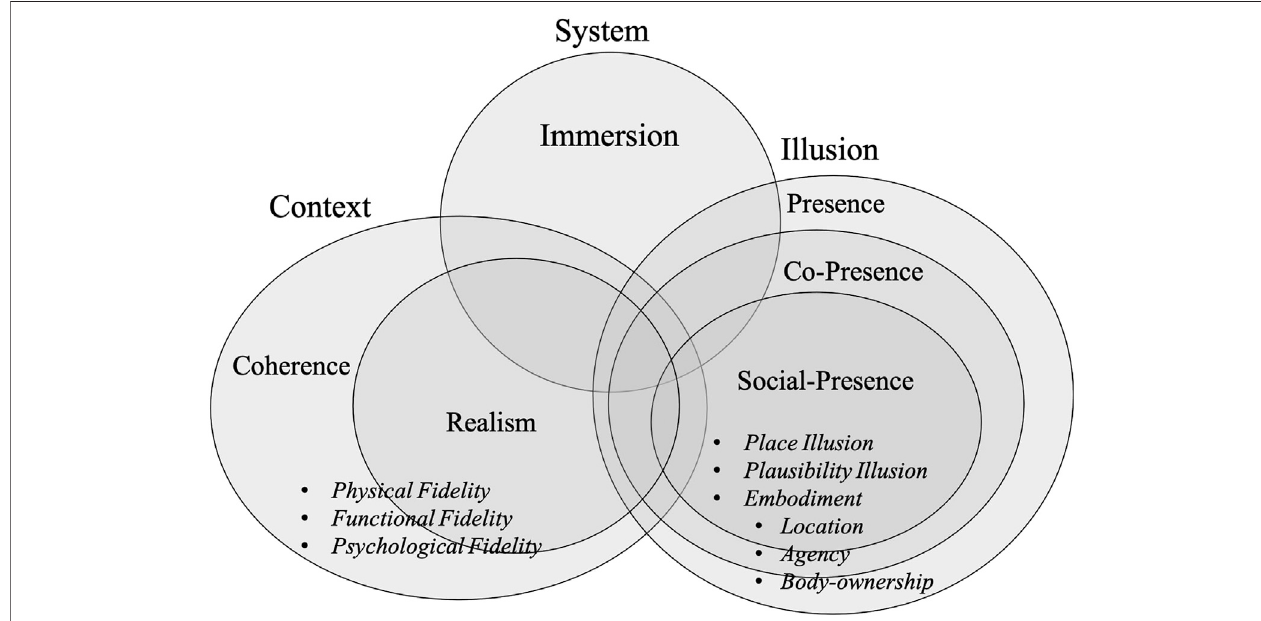
FIGURE 2 | Venn diagram model for quality of VR